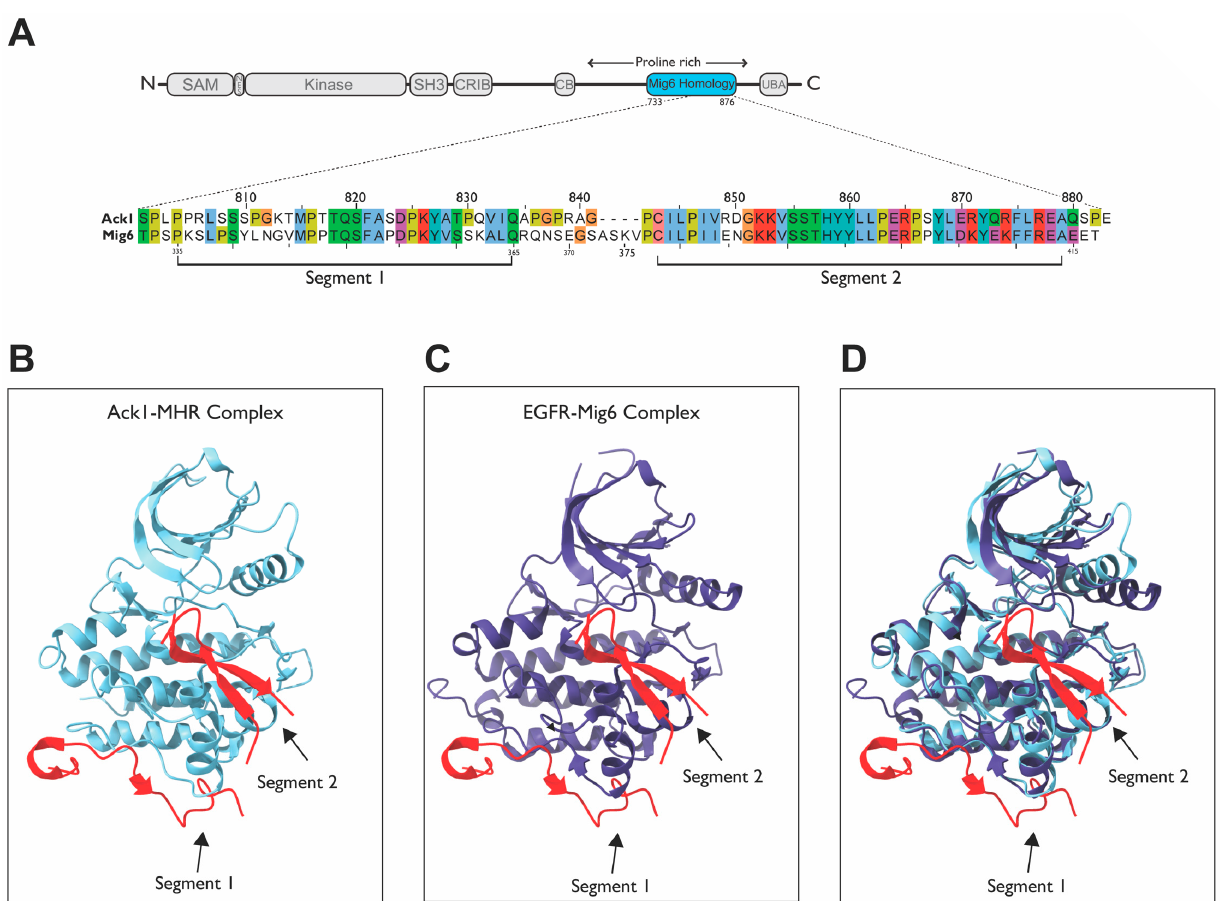
Figure 12. Sequence and structural comparison of Mig6 and MHR. ( A ) Sequence alignment between Ack1 and Mig6; ( B ) ClusPro predicted the Ack1-MHR complex [133,134] (PDB: 4EWH; Ack1, light blue; MHR, red); ( C ) EGFR-Mig6 complex (PDB: 4ZJV; EGFR, purple; Mig6, red). ( D ) Overlay of the Ack1-MHR and EGFR-Mig6 complexes from panels ( B , C ).